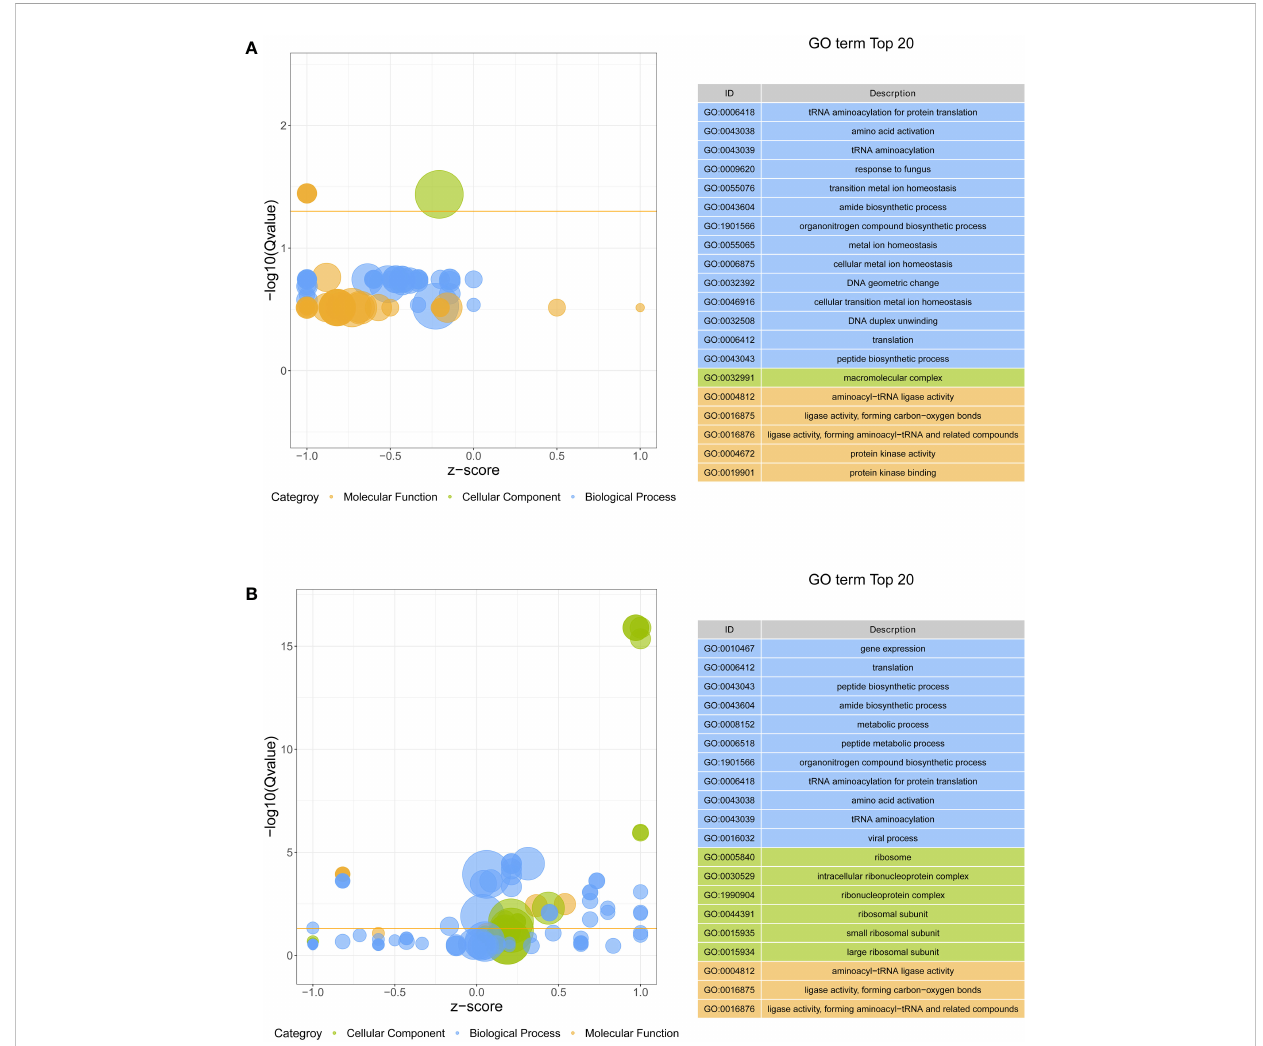
FIGURE 3 Gene ontology (GO) enrichment analysis of DEGs in each comparison group. (A) S4383-0-G vs R4345-0-G, (B) S4383-6-G vs R4345-6-G. Bubble plot showing the top 20 enriched GO terms in biological process (blue), molecular function (orange) and cell component (green). The y-axis belongs to -log10 (Q value), and the x-axis belongs to z-score. The horizontal line indicates the signi fi cance threshold (Q